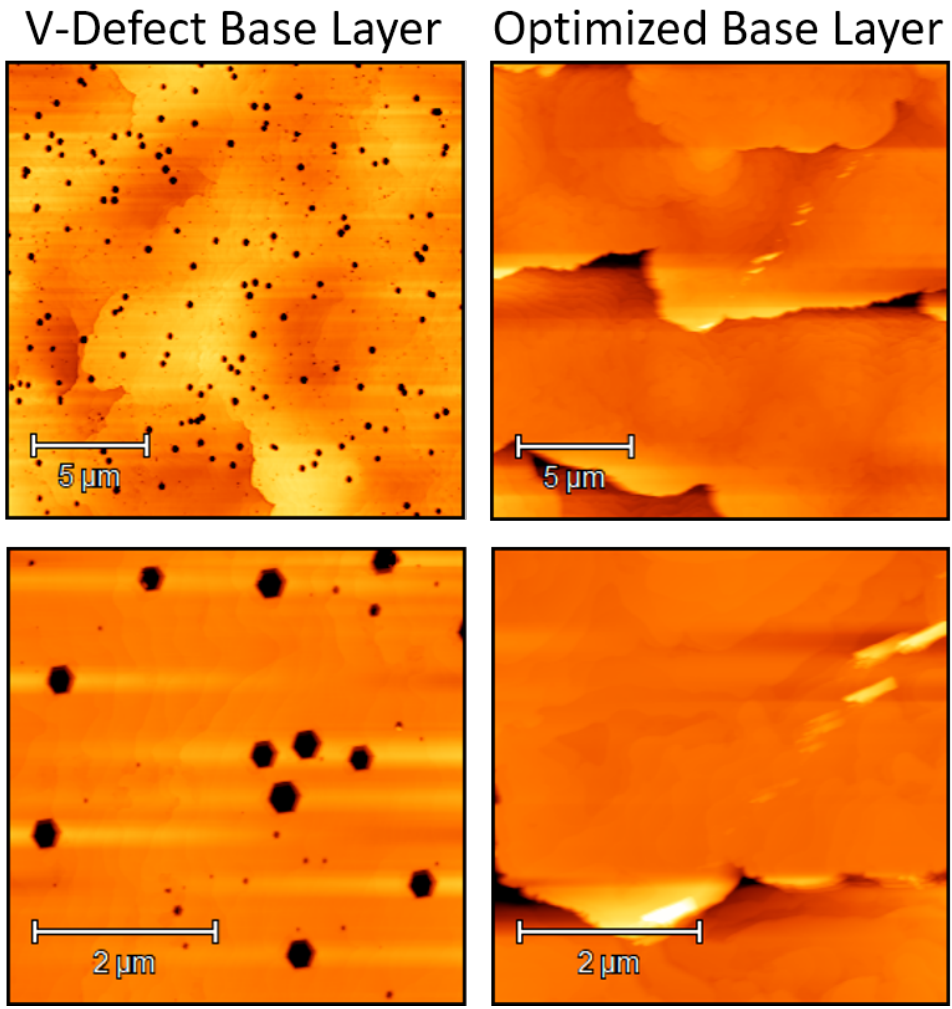
Figure 2. ( Top ) 20 × 20 µ m and ( bottom ) 5 × 5 µ m AFM scans for base layers containing V-defects and for optimized base